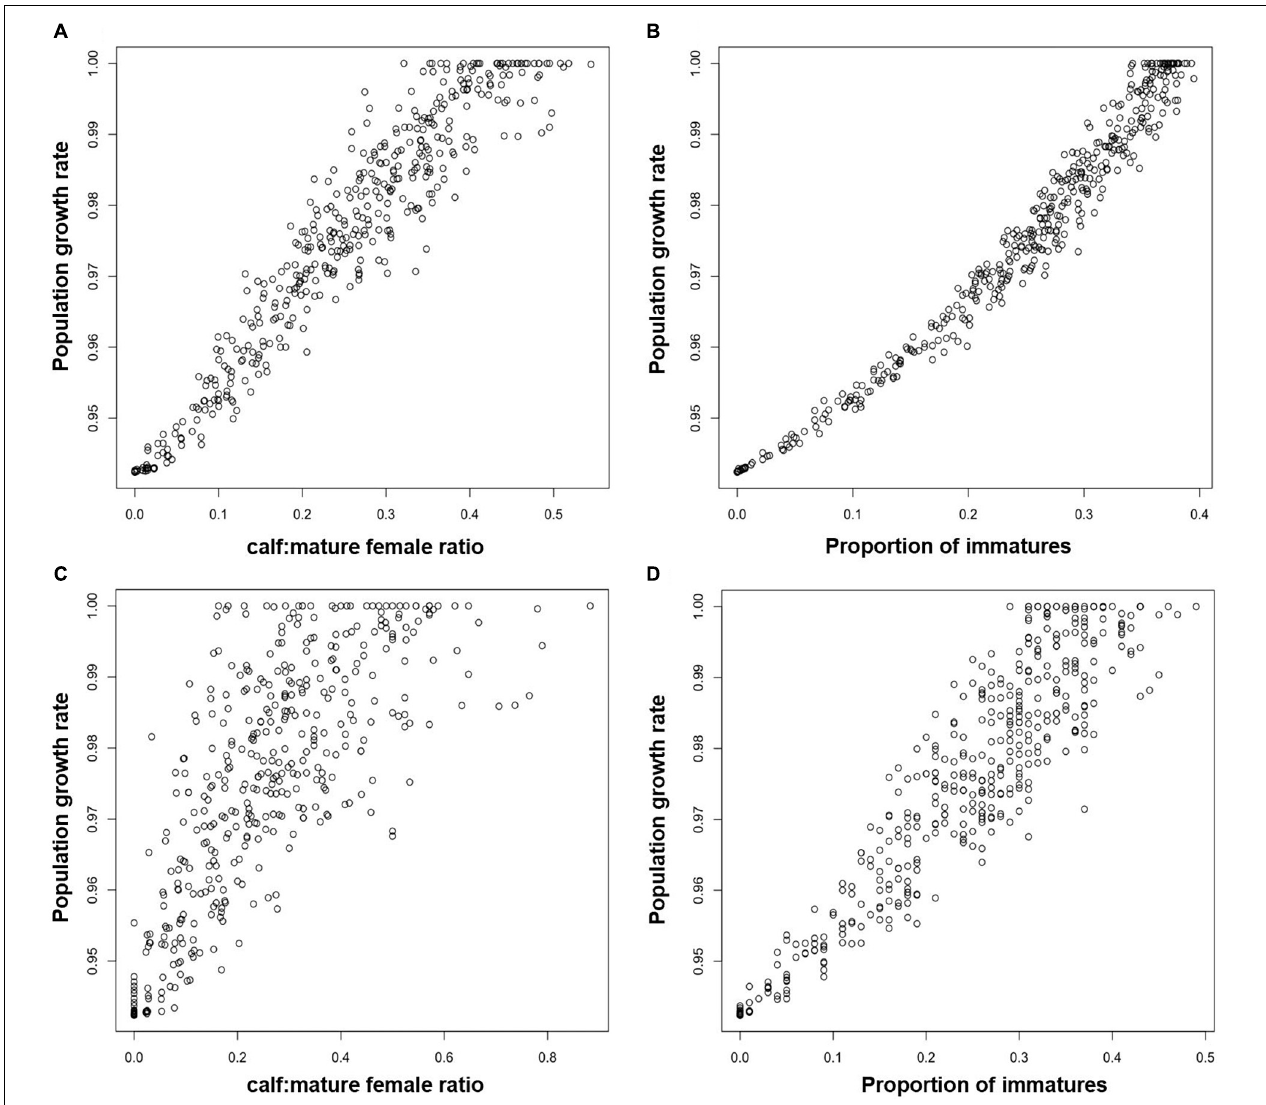
FIGURE 5 | Relationship between the long term growth rate of a Blainville’s beaked whale population and (A) the ratio of calves to mature females estimated from a random sample of 1,000 animals, (B) the proportion of immature animals estimated from a random sample of 1,000 animals (C) the ratio of calves to mature females estimated from a random sample of 100 animals, (D) the proportion of immature animals estimated from a random sample of 100